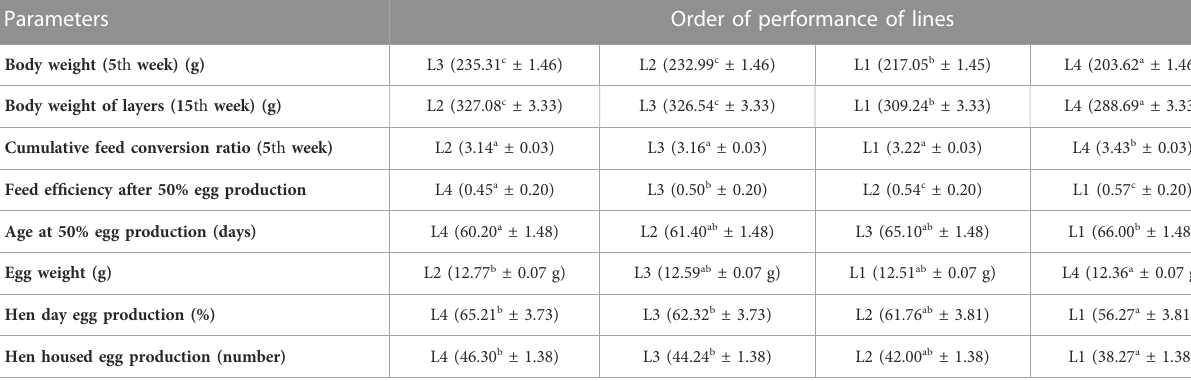
TABLE 10 Order of preference of the different lines for the different production and reproduction characters. Parameters Order of performance of